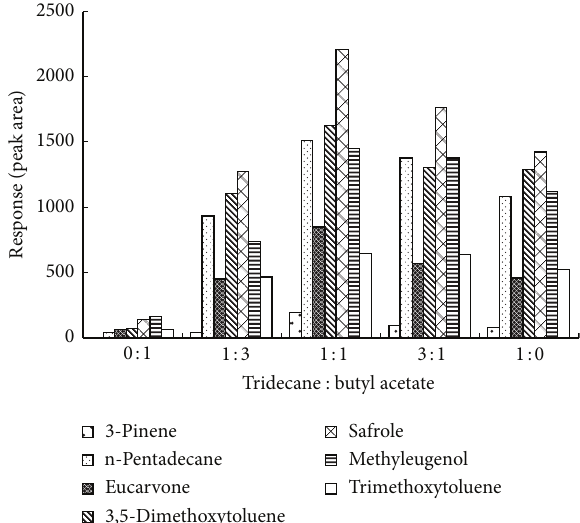
Figure 2: Comparison among different scales of n-tridecane in the extracting solvent on the relative peak area of the seven main compoundsfromHerbaAsari.Powderedsample,0.500 g;extraction solvent volume, 0.6 𝜇 L; particle size, 100mesh; extraction time, 20 min, extraction temperature, 70 ∘ C; the percent between two mixed solvent, 1: 1 (volume).